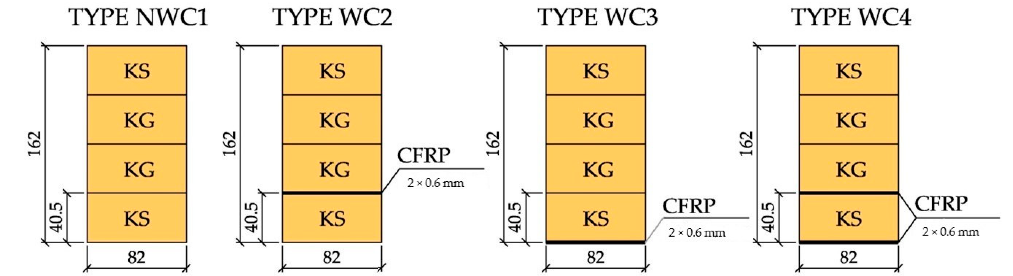
Figure 1. Cross-sections of the beams tested [dimensions in mm].